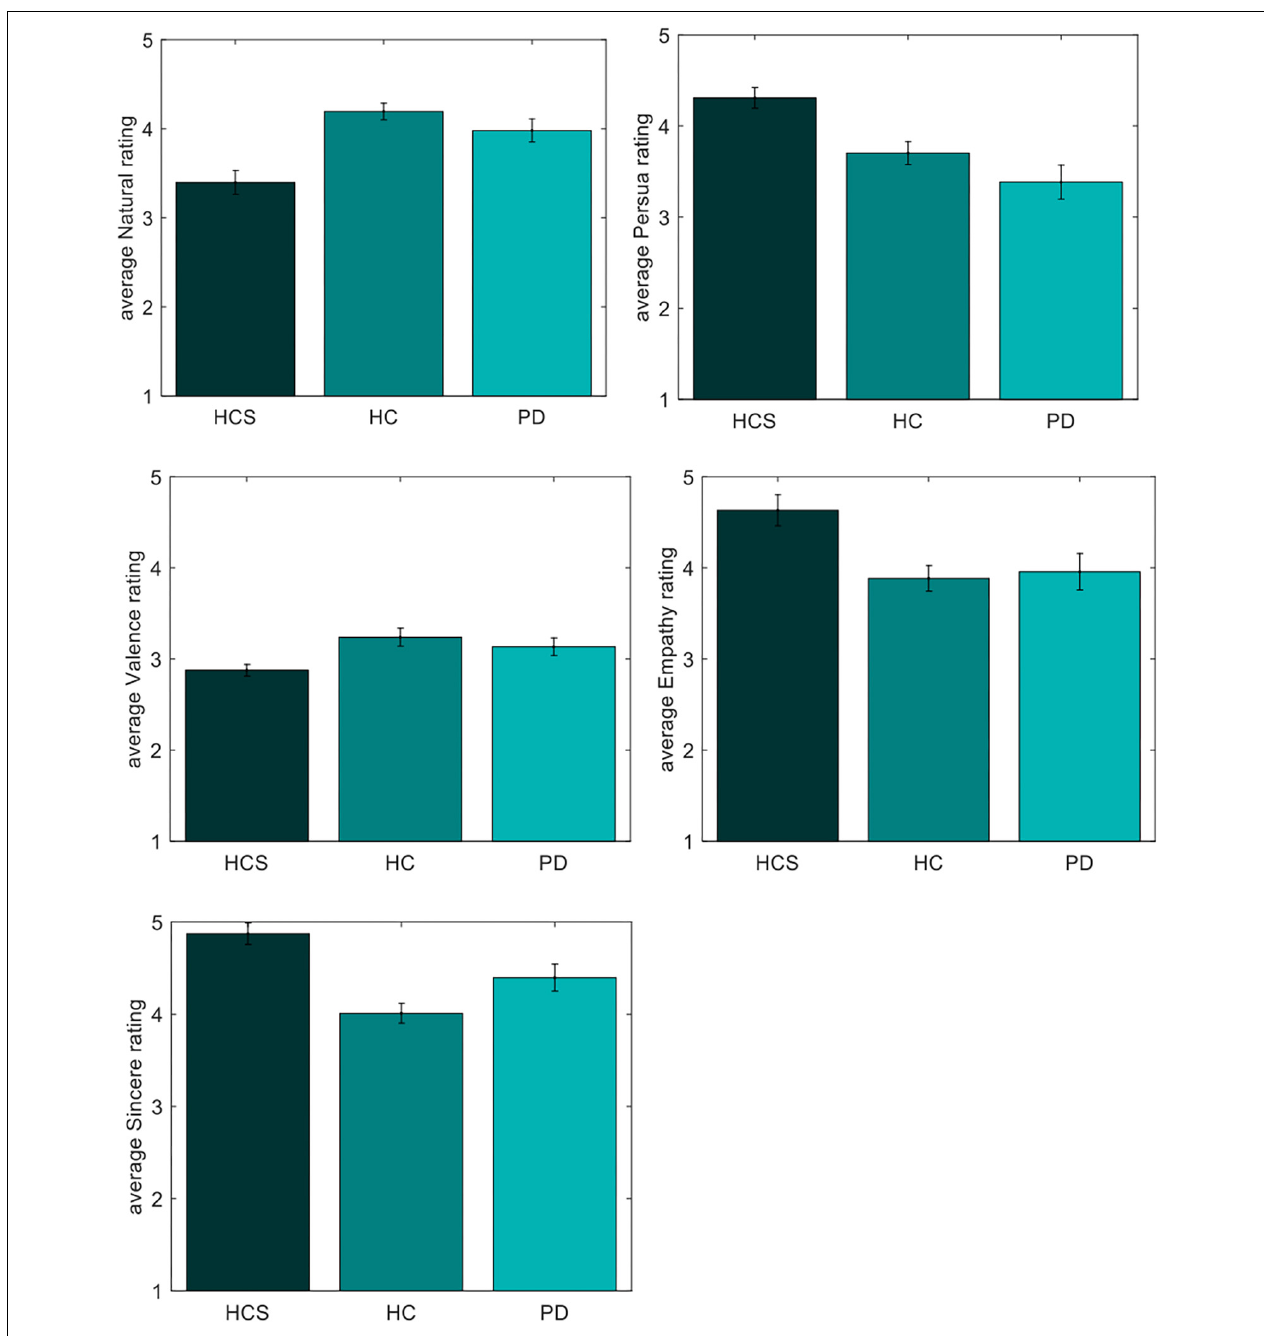
FIGURE 7 | Individual ratings of negative expressions for naturalness, persuasiveness, valence, empathy, and sincerity.